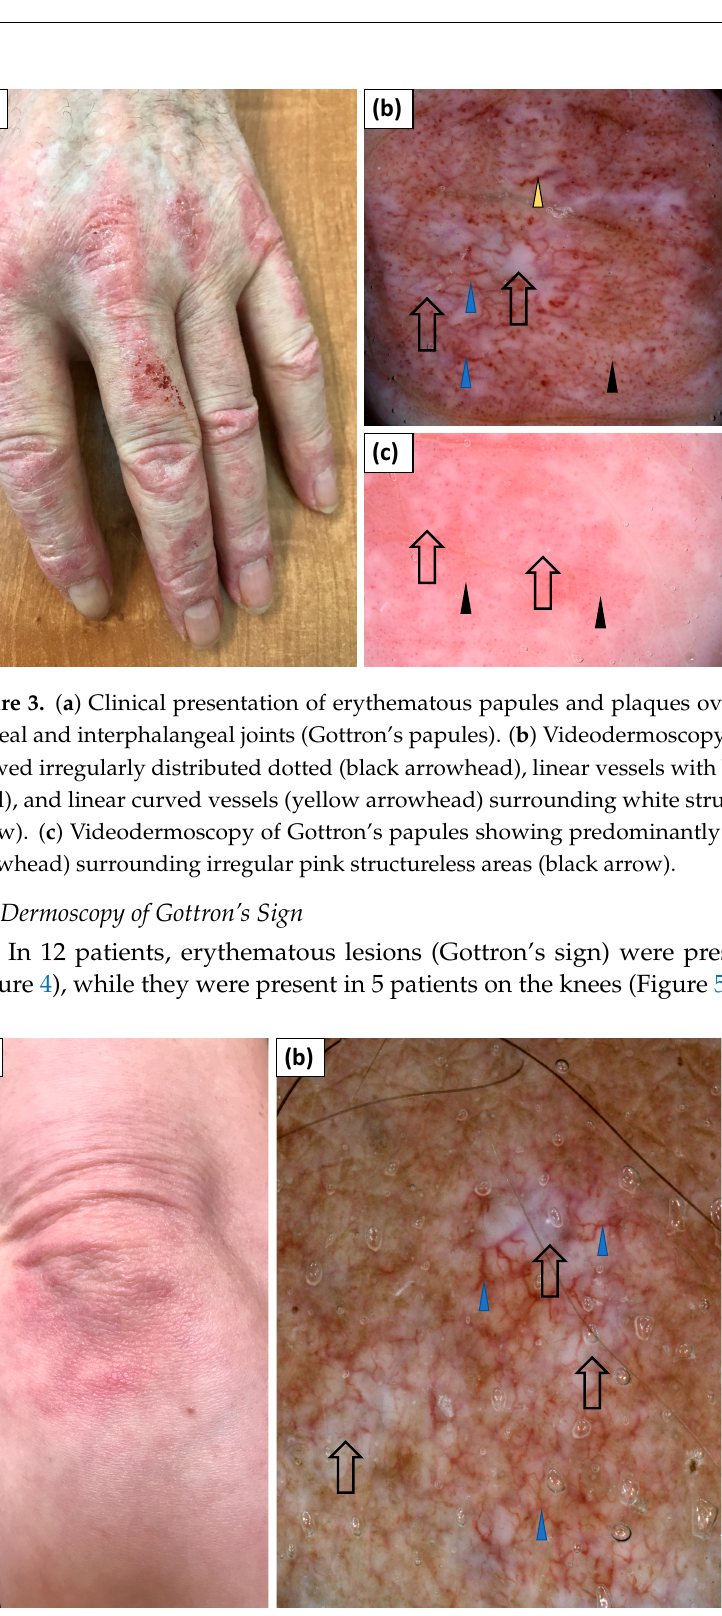
Figure 5. ( a ) Clinical presentation of Gottron’s sign over the knee. ( b ) Videodermoscopy of Got- tron’s sign showed irregularly distributed dotted (black arrowhead) and multiple linear vessels with branches (blue arrowhead) surrounding white structureless areas (black arrow). Follicular plugs (yellow arrowhead) were present as well.